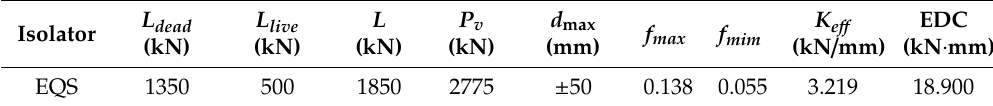
Table 2. Design properties of EQS